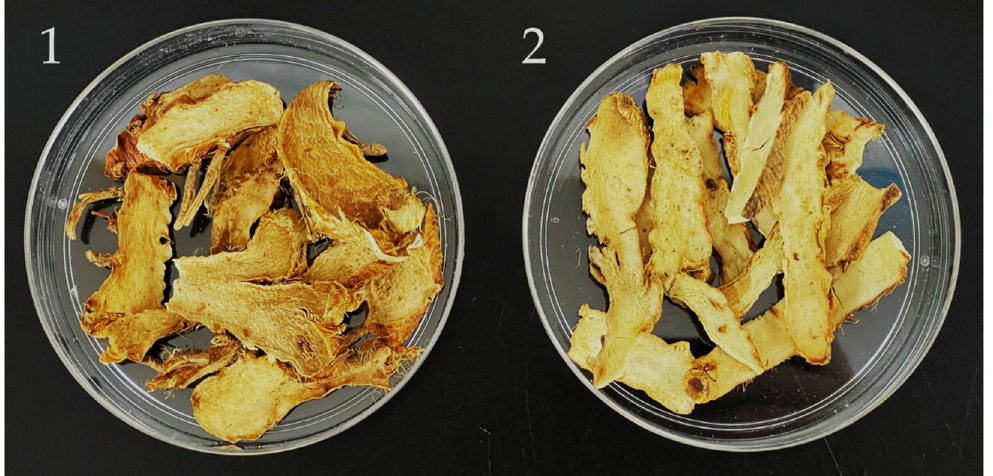
Figure 1. Non-salt-fried (1) and salt-fried (2) rhizomes of Anemarrhena asphodeloides were used in the study.